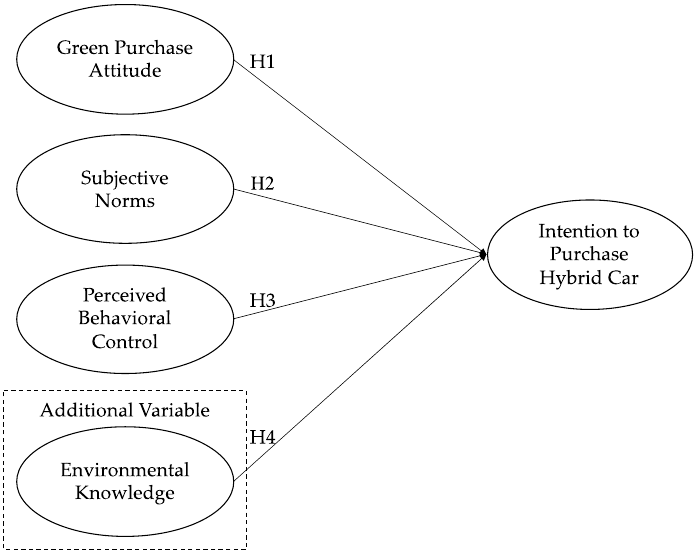
Figure 1. Research framework. 229